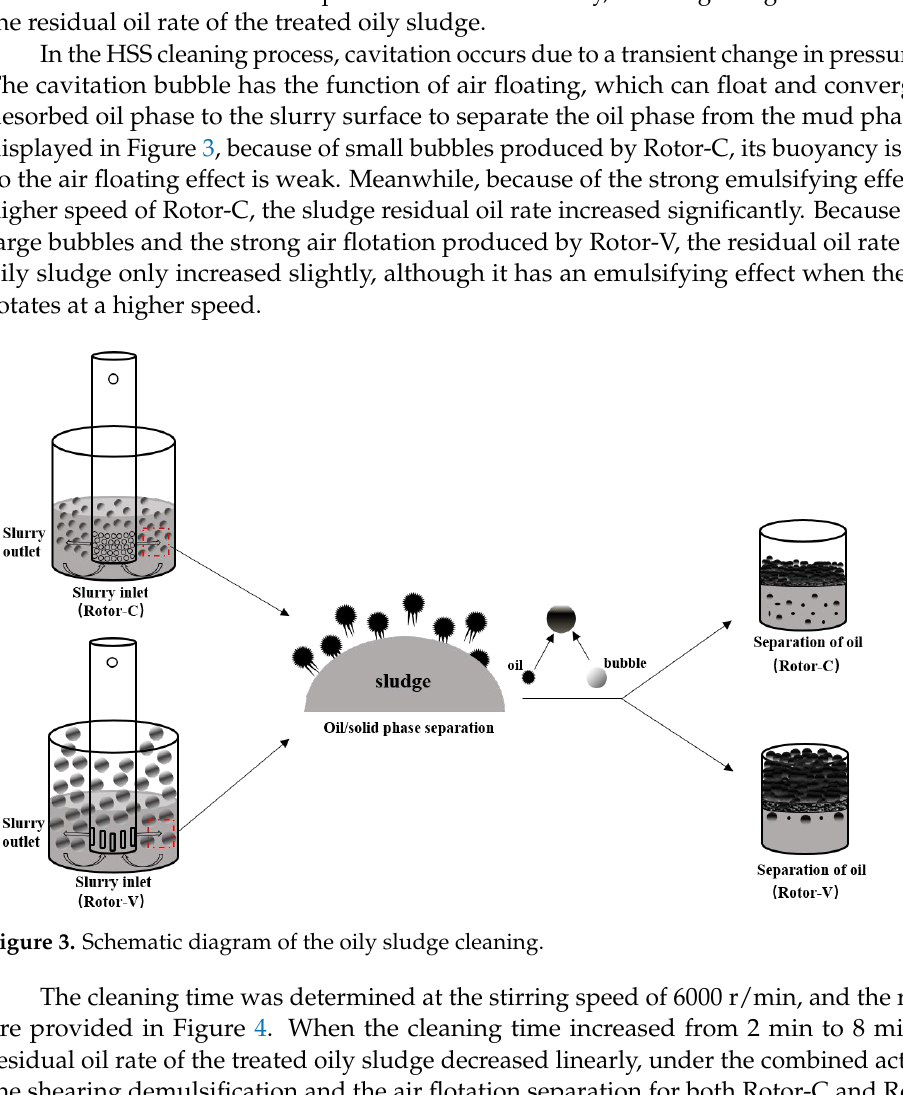
Figure 4. Effects of the cleaning time on the residual oil rate of the oily sludge. 3.2. Effects of Rotor Combination Mode on Residual Oil Rate of Oily Sludge Based on the single-factor experiment, the stirring speed and cleaning time were de- termined for Rotor-C and Rotor-V. In this section, the two-stage combination mode was used to further decrease the residual oil rate of the oily sludge. There were two kinds of rotor combination modes: Rotor-C followed by Rotor-V, and Rotor-V followed by Rotor- C. Table 1 shows the test results of the residual oil rate of the two-stage oily sludge clean- ing. After the HSS cleaning by Rotor-V and then Rotor-C, the residual oil rate of the oily